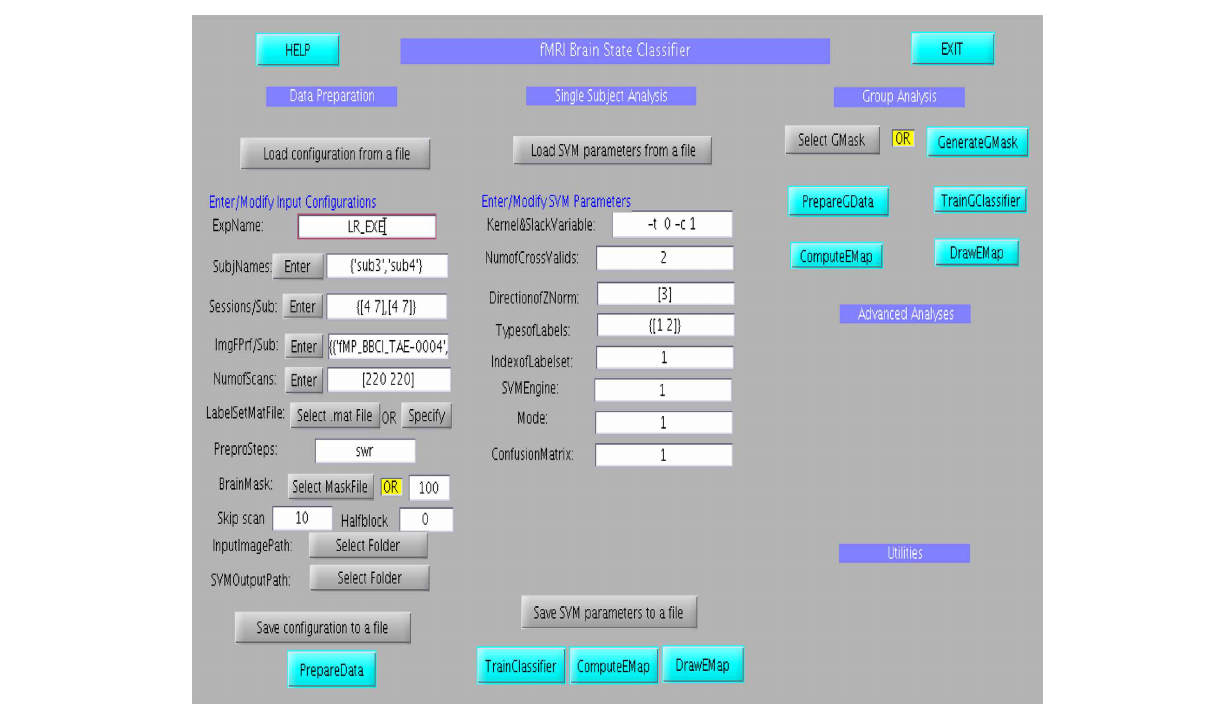
FIGURE 6 | Graphical User Interface for the offline subject-dependent classification and analysis. It consists of three main columns namely “Data Preparation,” “Single Subject Analysis,” and “Group